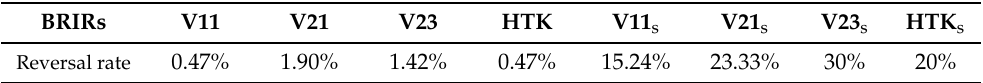
Table 3. Reversal rate when localizing virtual sources generated with V11, V21, V23 and HTK in TestDynamic and with V11 s , V21 s , V23 s and HTK s in